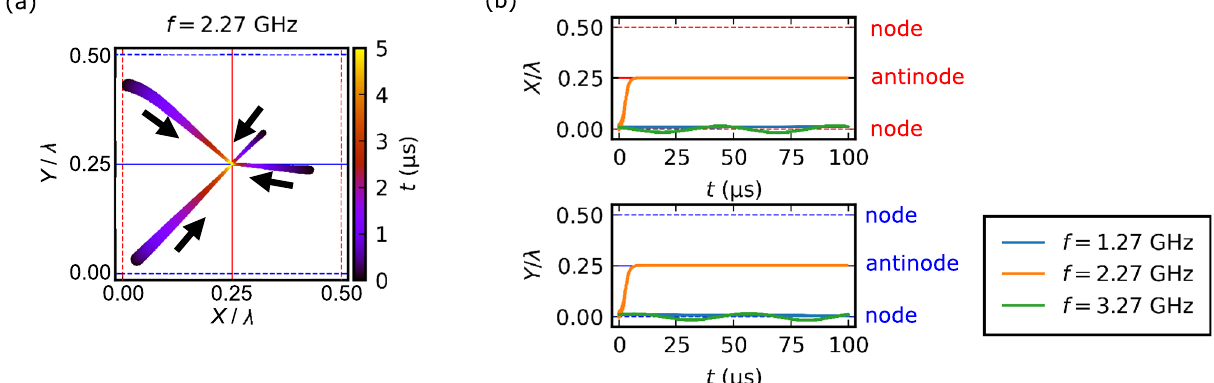
Figure 3. Skyrmion trap at antinodes. ( a ) Trajectories of skyrmions in the presence of standing SAWs with the resonant frequency in the x - and y -direction. Skyrmions are initially placed at four different positions. Colors of the data indicate the time evolution. Red (blue) dashed and solid lines denote nodes and antinodes of ǫ xx ( ǫ yy ), respectively. ( b ) Time dependence of skyrmion position ( X and Y coordinates) when applying standing SAWs 1.27 GHz, 2.27 GHz (resonant frequency), and 3.27 GHz]. Here the coordinates with different frequencies [ f = v / f ) to compare the data of different frequencies. Skyrmons are initially are normalized by wavelength ( (cid:31) = ( 0.01 (cid:31) , 0.01 (cid:31) ) . For detailed skyrmion dynamics, see also Supplementary Movie placed at R ( 0 ) = fabricated on a piezoelectric substrate. Four IDT electrodes are prepared outside of the ferromagnetic film to apply counter-propagating SAWs along the x and y directions. The SAWs applied along the x and y directions are described by